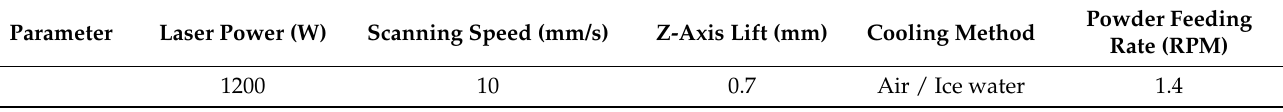
Figure 3. Preparation of tensile sample: ( a ) straight thin-walled sample, ( b ) cutting positions of the tensile sample, ( c ) size of the tensile sample. Table 1. The main process parameters.